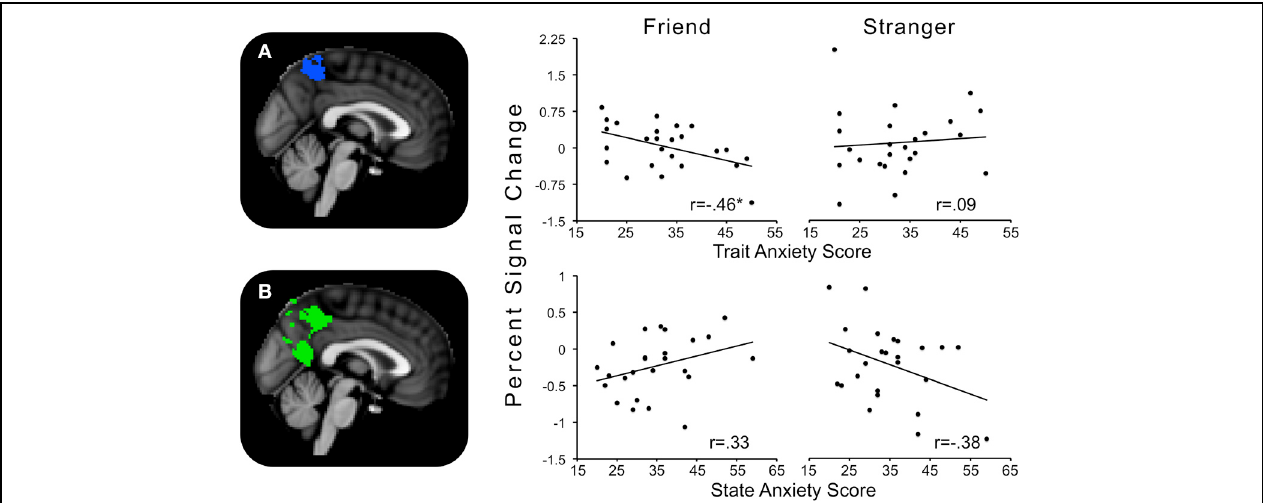
FIGURE 5 | Regions showing significant interactions between state or trait anxiety and Friend minus Stranger conditions. (A) Precuneus activity significantly related to trait anxiety; (B) precuneus activity significantly related to state anxiety. ∗ p ’s <